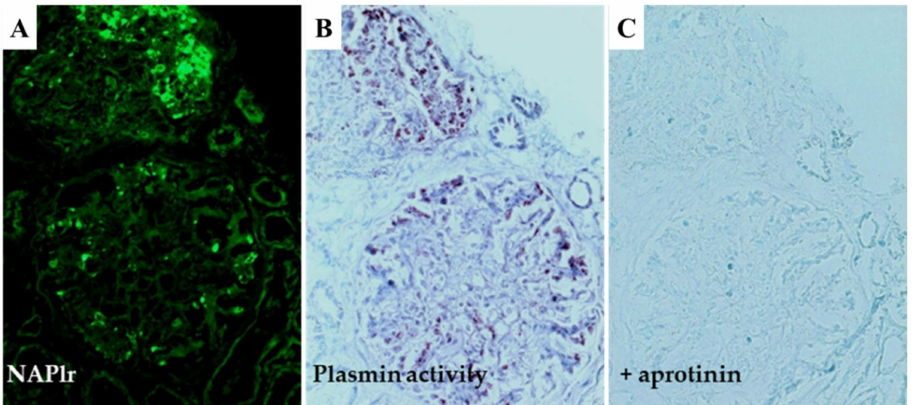
Figure 10. In situ zymography for plasmin activity. ( A ) Positive NAPlr staining in the glomeruli of a PSAGN patient 18 days after onset. ( B ) Prominent plasmin activity was observed in a similar distribution to NAPlr deposition in the same glomeruli as shown in ( A ). This activity was completely inhibited by the addition of aprotinin ( C ). NAPlr: nephritis-associated plasmin receptor, PSAGN: post- streptococcal acute glomerulonephritis. Photographs are cited from a previously published report [11], where details of all the staining methods have been described. Original magnifications: ×